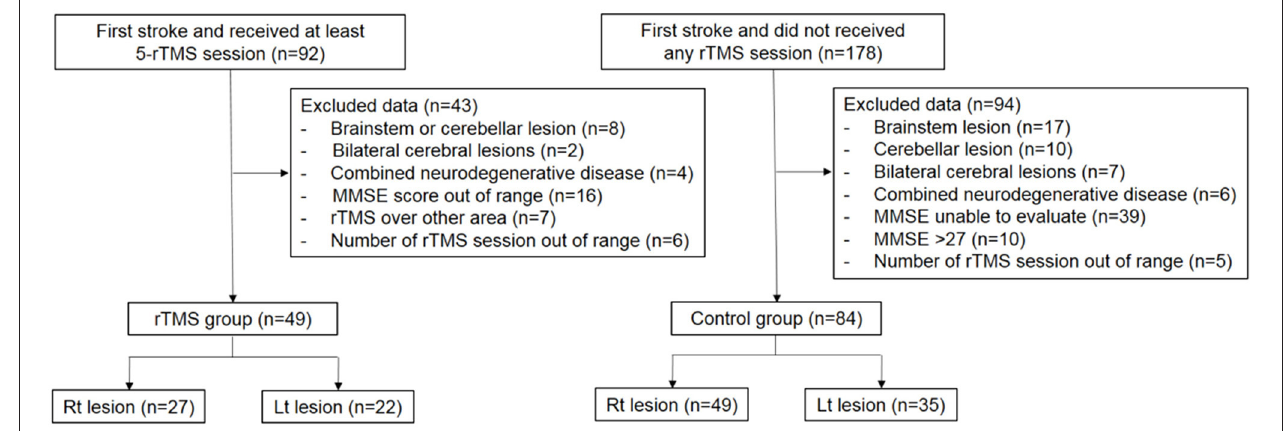
FIGURE 1 | Flow chart of subject selection for analyse. rTMS, repetitive Transcranial Magnetic Stimulation; MMSE, Mini-Mental State Examination.